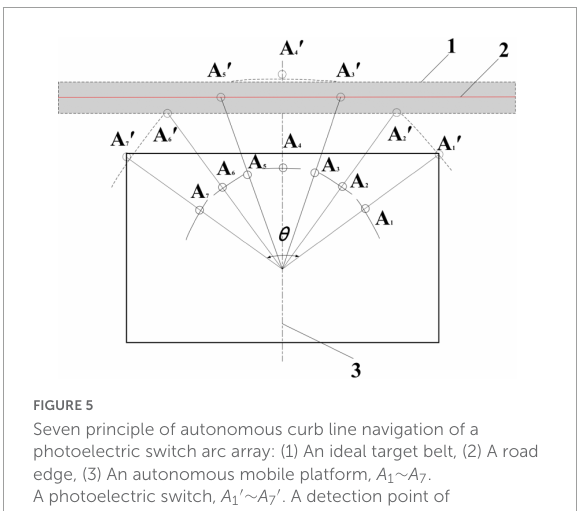
FIGURE5 Seven principle of autonomous curb line navigation of a photoelectric switch arc array: (1) An ideal target belt, (2) A road edge, (3) An autonomous mobile platform, A 1 ∼ A 7 . A photoelectric switch, A 1 (cid:48) ∼ A 7 (cid:48) . A detection point of photoelectric switch, θ . The central angle of the photoelectric switch arc